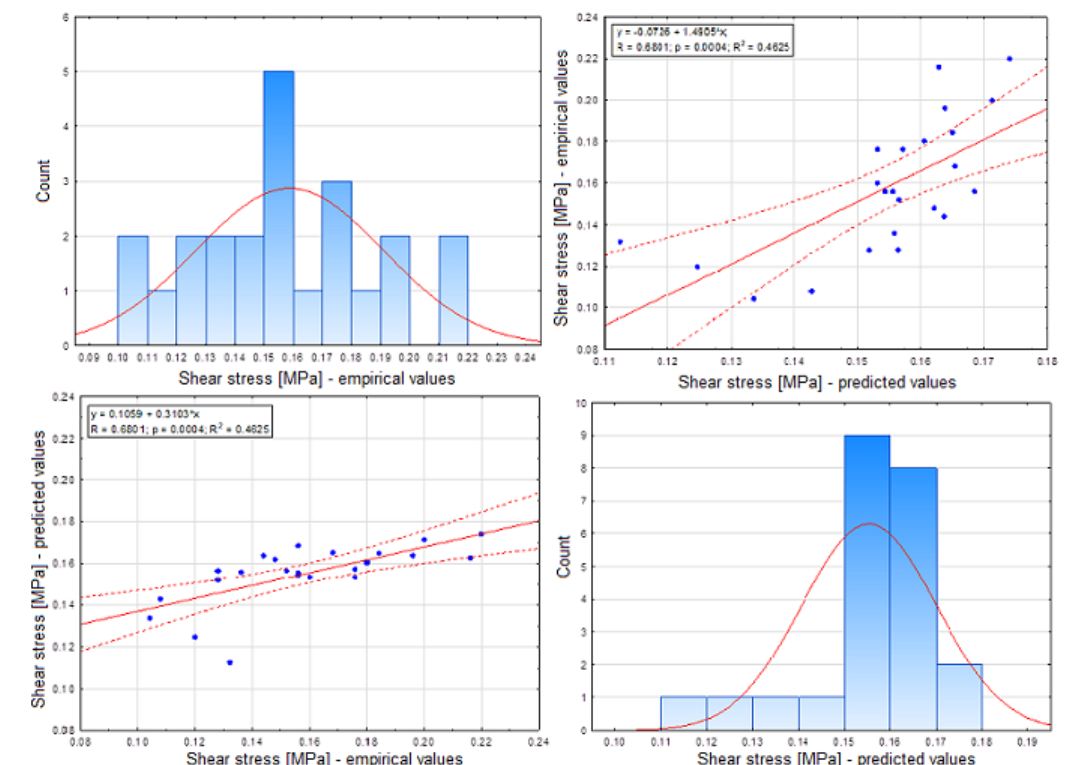
Figure 4. The scatter matrix graph for the validation dataset (MLPSC_0.4_0.5 model).